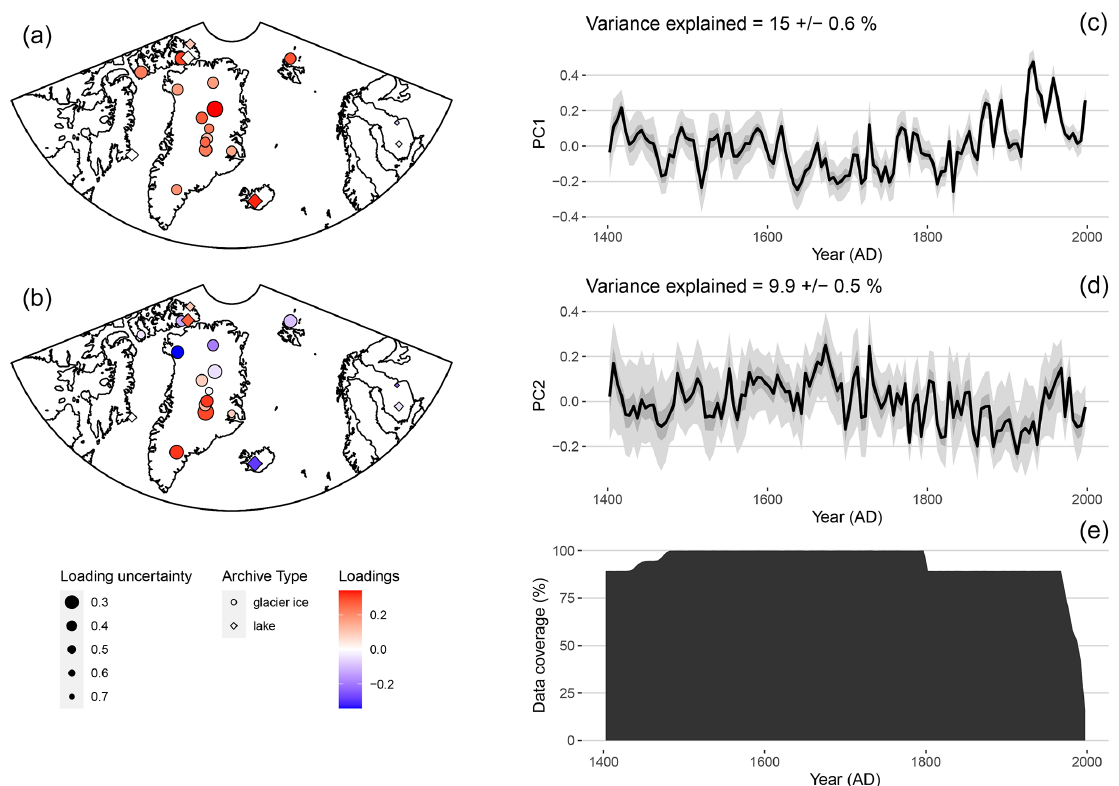
Figure 9. The spatial loading pattern (a, b) and time series (c, d, e) for the first principal component shown in panels (a, c) . The results for the second PC are shown in panels (b, d) . The data density through time is shown in panel (e) . For the maps, the median loadings of the ensemble are shown by the color scale, and the standard deviation of the loadings across ensemble members is depicted by the size of the markers, with larger markers showing smaller uncertainties. For the time series plots, the median of the ensemble is shown in black, and the 50% and 95% highest-probability density regions are shown in dark and light gray, respectively.